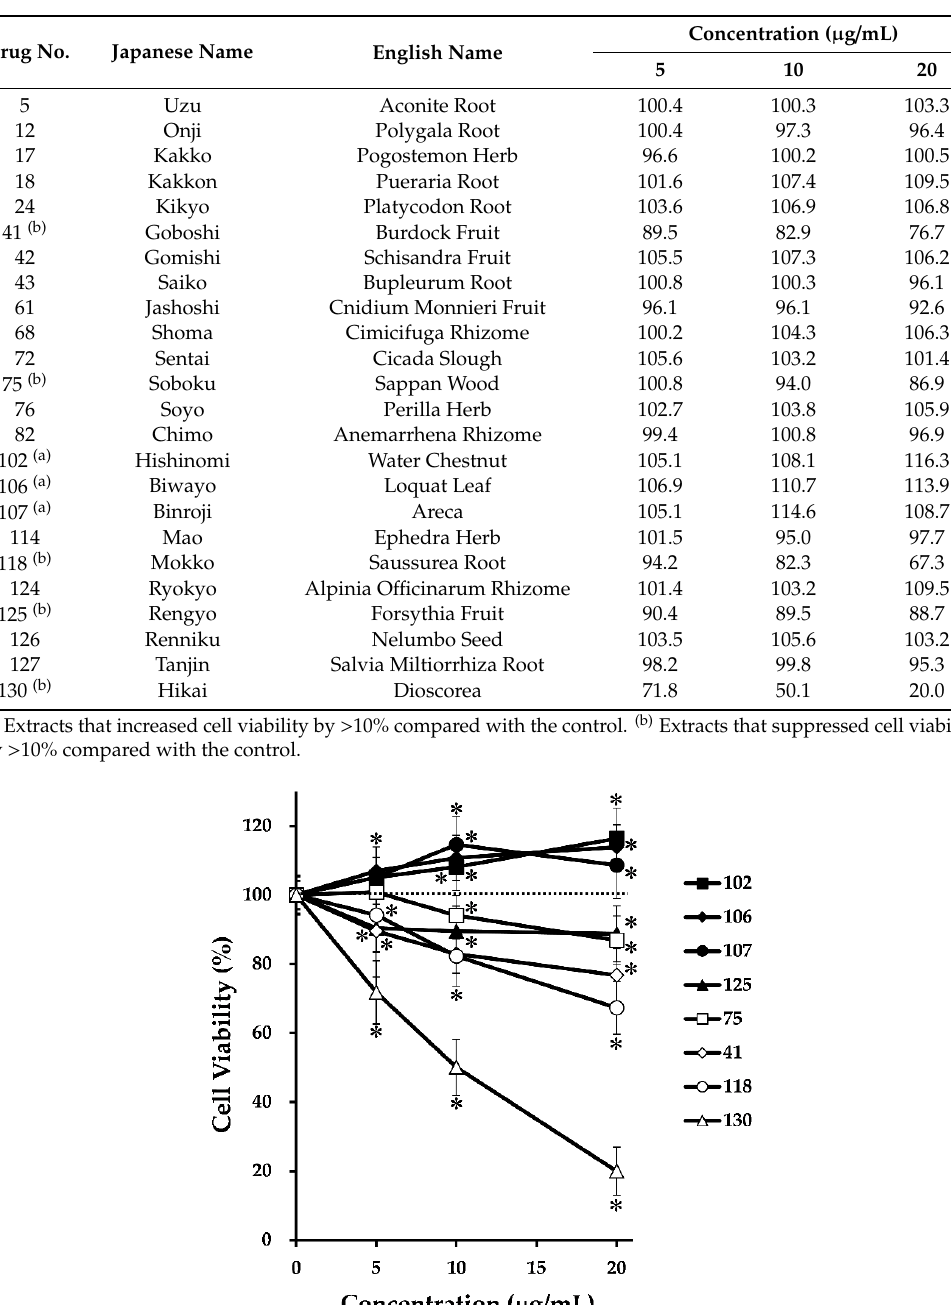
Table 1. E ff ects of selected 24 crude extracts on the proliferation.